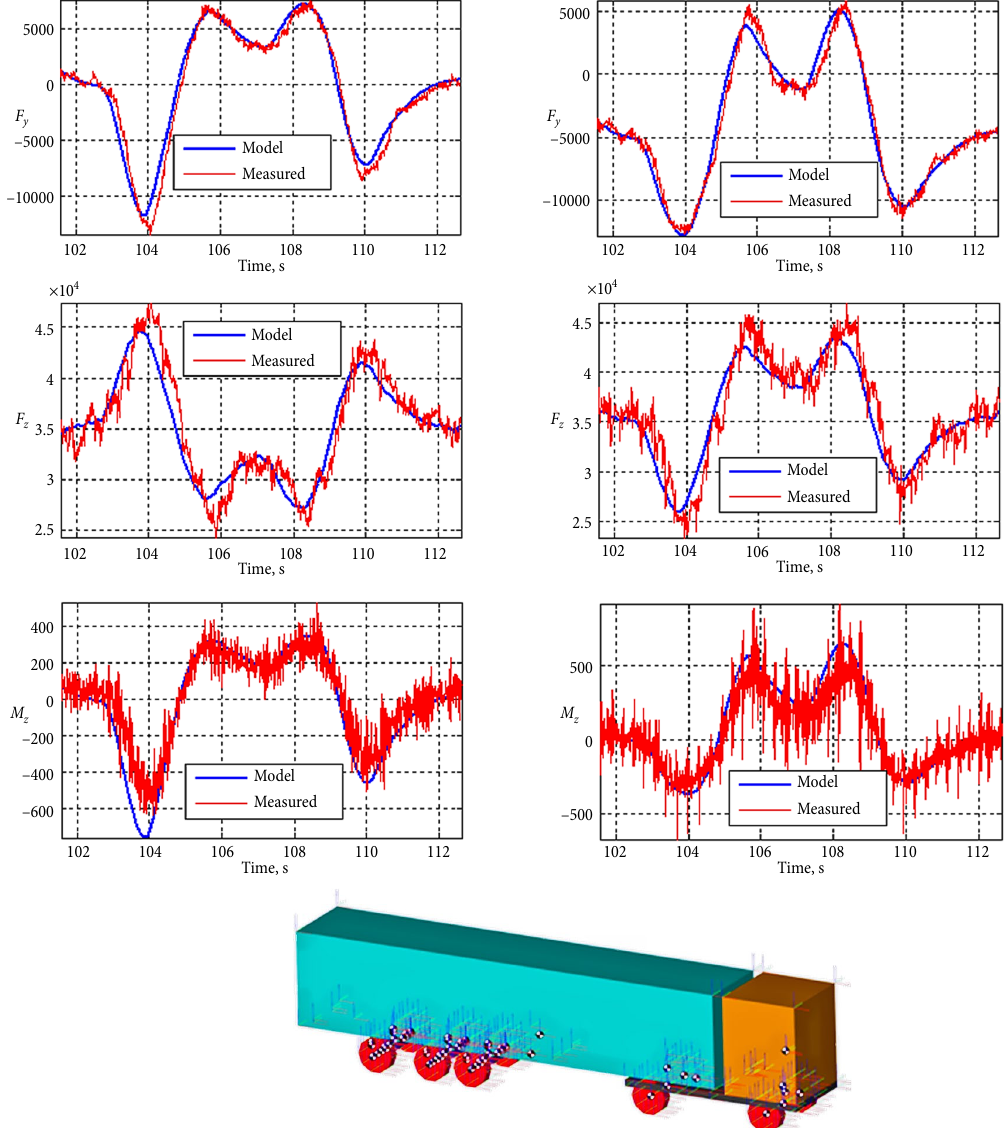
Fig. 9. Wheel forces validation during lane